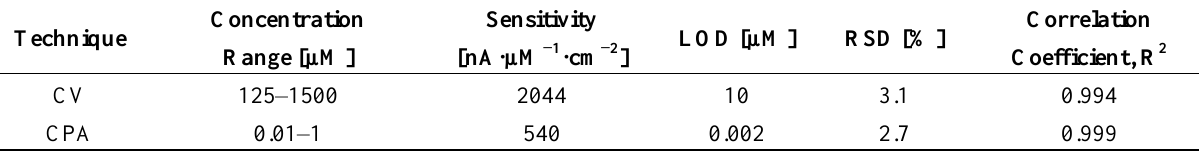
Table 6. Analytical parameters obtained for DA detection at µ-SZ-GEC quasi-microelectrode using CV and